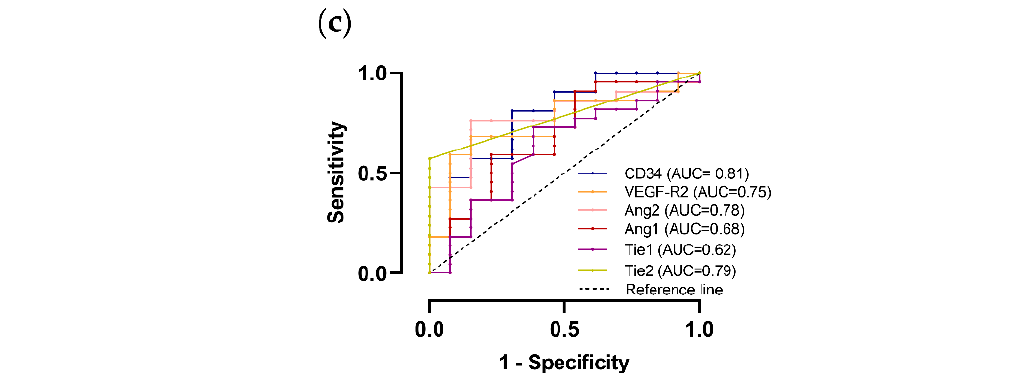
Figure 5. Graphic representation of ROC curve to distinguish adrenocortical carcinoma (ACC) and total adrenocortical adenomas (ACAt) ( a ); ACC and adrenocortical adenoma with Cushing syndrome (ACAc) ( b ); ACC and non-functioning adrenocortical adenoma (ACAn) ( c ) with the respective area under the curve (AUC).